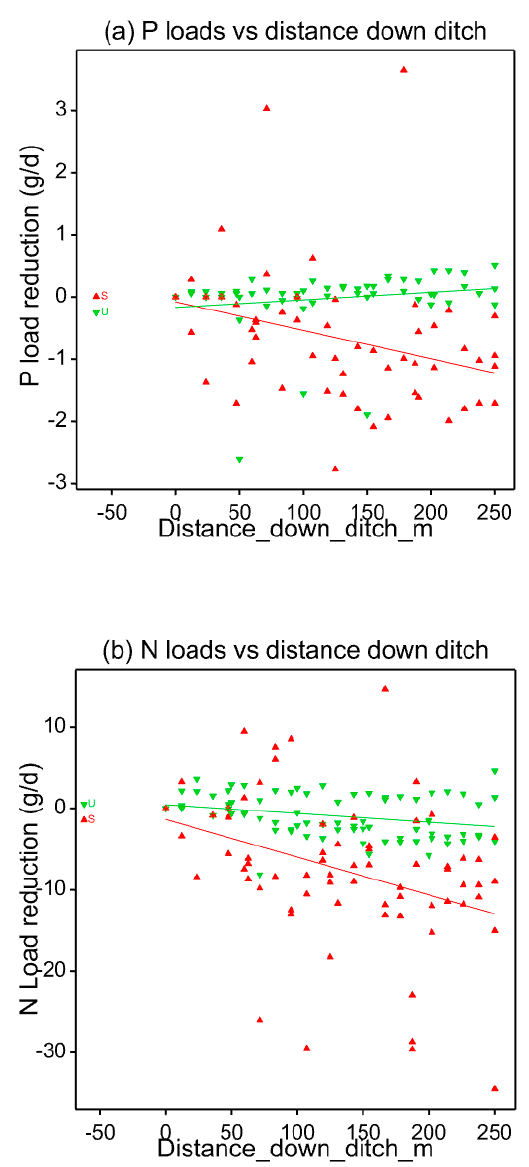
Figure 4. Estimation of ( a ) SRP and ( b ) NO 3 -N retention rates for ditches seeded with watercress, and those not seeded. Slopes of load reduction for watercress ditches (red) are equivalent to − 0.0092 g P / m 2 ditch / d and − 0.092 g N / m 2 ditch / d, assuming an average ditch width of 0.5